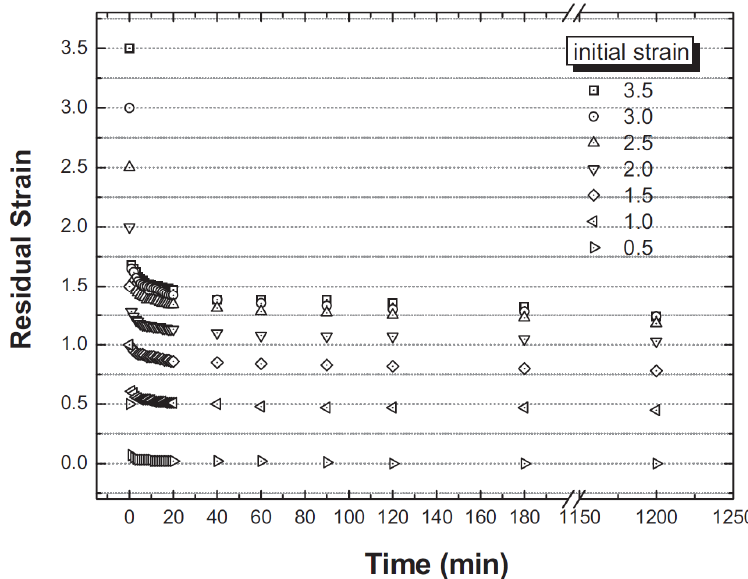
Figure 6. Time dependence of the residual strain of LCE1 uniaxially stretched to different initial strains at room temperature [20]. For fractional strains above 0.5 (or, 50%), the elastomer retains part of the imparted strain. The amount of strain retained appears to increase with the value of initial strain. Most of the strain-recovery occurs within ca . 20 min of releasing the elastomer. Adapted with permission from [20]. Copyright 2012 John Wiley and